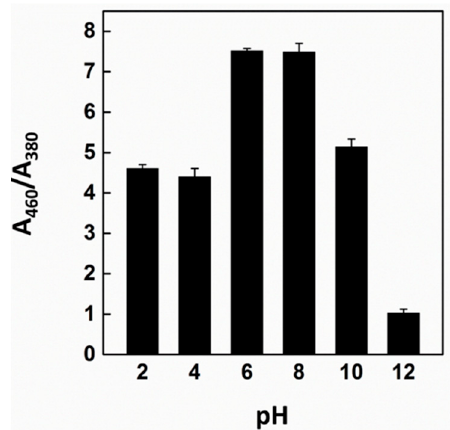
Figure 2. The color changes of CG-Co 2+ complex at different pH. UV-vis analysis at pH conditions for colorimetric detection of cobalt. The concentration of cobalt is 2 ppm. Each experiment was performed three times.